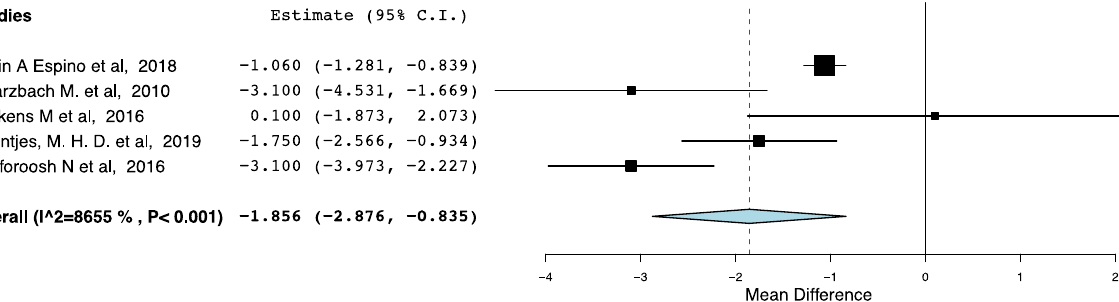
Figure 8. Forest plot: length of hospital stays (ERAS—traditional perioperative care). Only studies reporting LOS as mean ± SD where included in this meta-analysis.